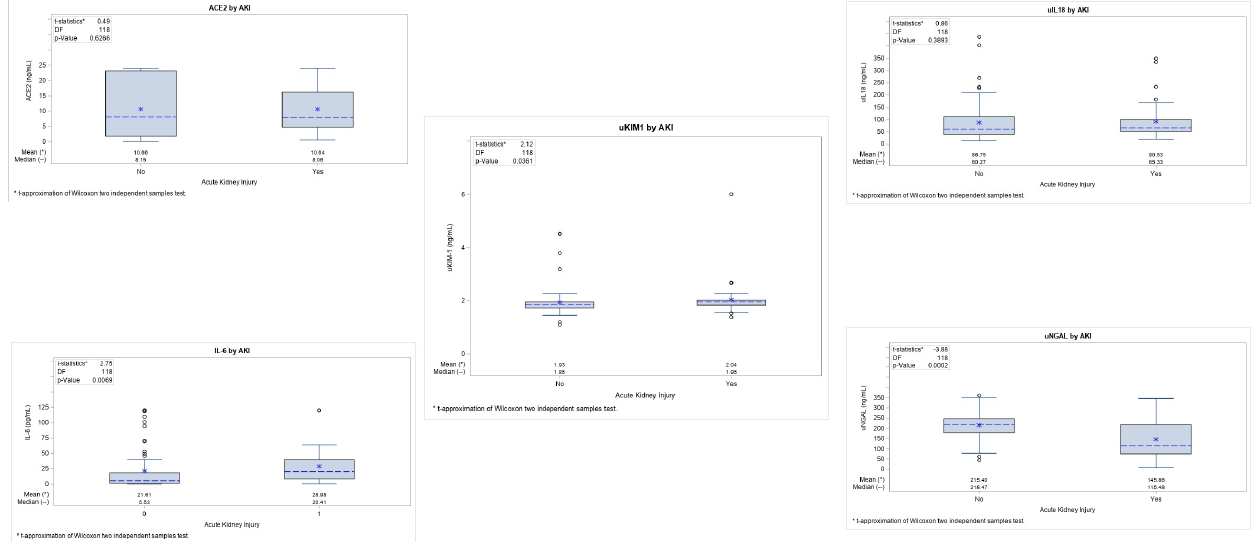
Figure 2. Comparison of biomarkers in COVID-19 patients with or without AKI.